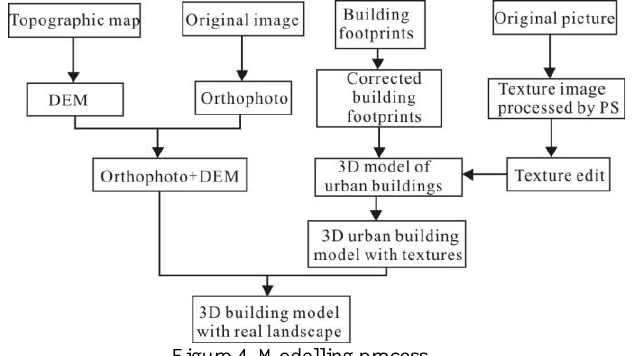
Figure 4. Modelling